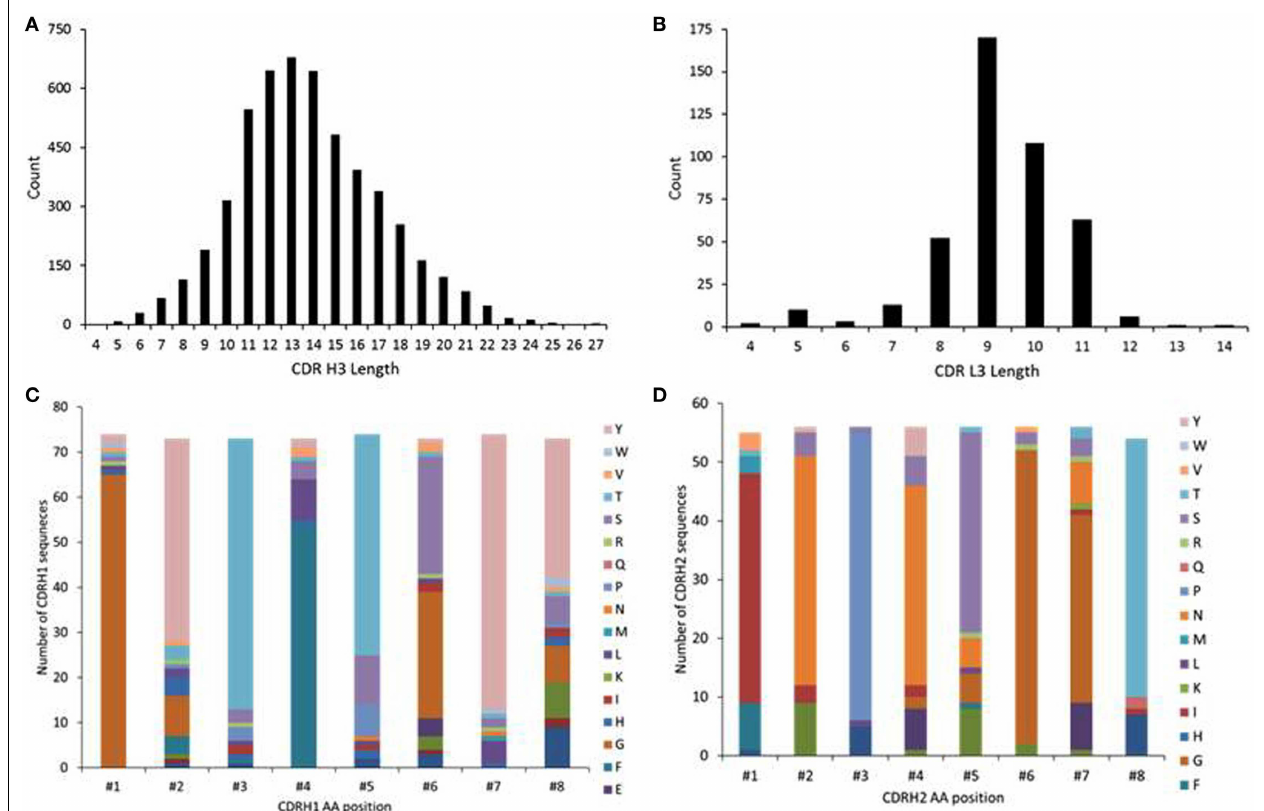
FIGURE 3 | Distributions of amino acid length in (A) CDRH3, (B) CDRL3 and amino acid compositions in (C) CDRH1 and (D) CDRH2 as derived using the gene families of IGHV1-2 and IGKV3-11 in human cord blood IgM library showing the CDR3 lengths diversity and pre-existing mutations at CDRH1 and H2